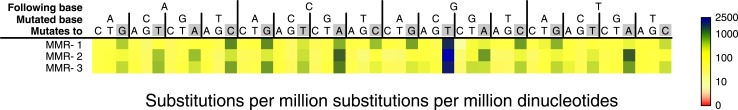
Somatic substitution frequency per million dinucleotides and per million substitutions for the individual MMR-deficient genomes.The first row lists the base following the mutated base, the second row the base that was mutated, and the third row the new base. Transitions are indicated by grey boxes. Frequencies are depicted color-coded following a logarithmic distribution as shown by the gradient on the right. The average R2 between the MMR-deficient tumors is 0.75.